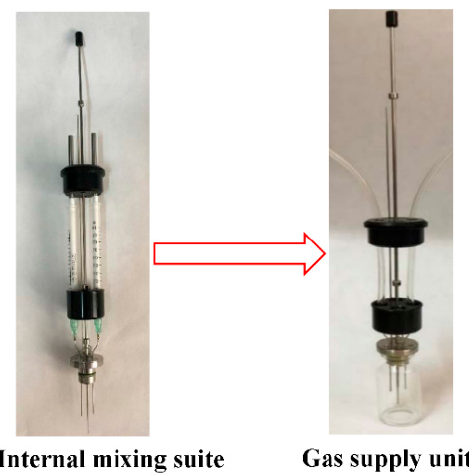
Figure 3. Photo of gas supply unit retrofitted by internal mixing suite.